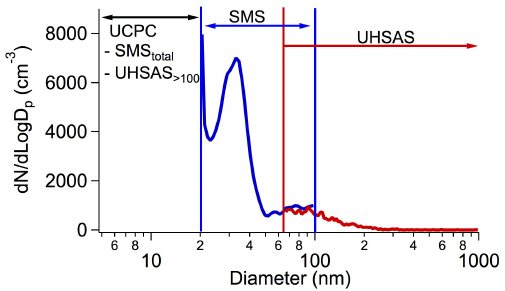
Figure 1. Characteristic size distribution showing the size range of the SMS and UHSAS (observed near 81.1 ◦ W in Lancaster sound, see Fig. 2a) . Number concentrations from 5 to 20nm ( N 5–20 ) were estimated by subtracting the sum of the SMS total number concen- tration ( N 20–100 ) and UHSAS number concentration greater than 100nm ( N > 100 ) from the total UCPC concentration (i.e. N > 5